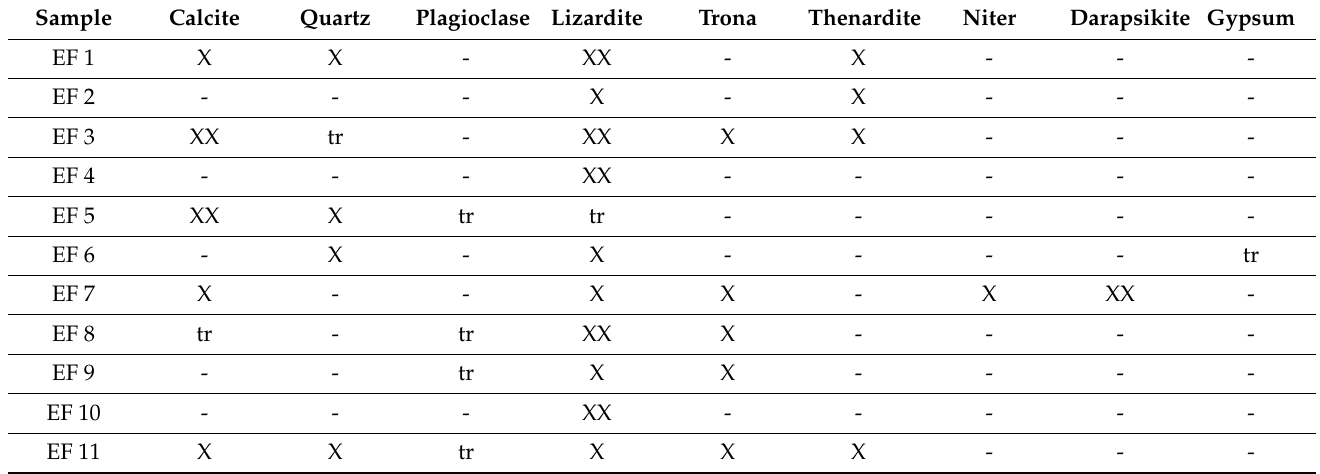
Table 1. Composition of the serpentinite efflorescence obtained by XRD analyses.